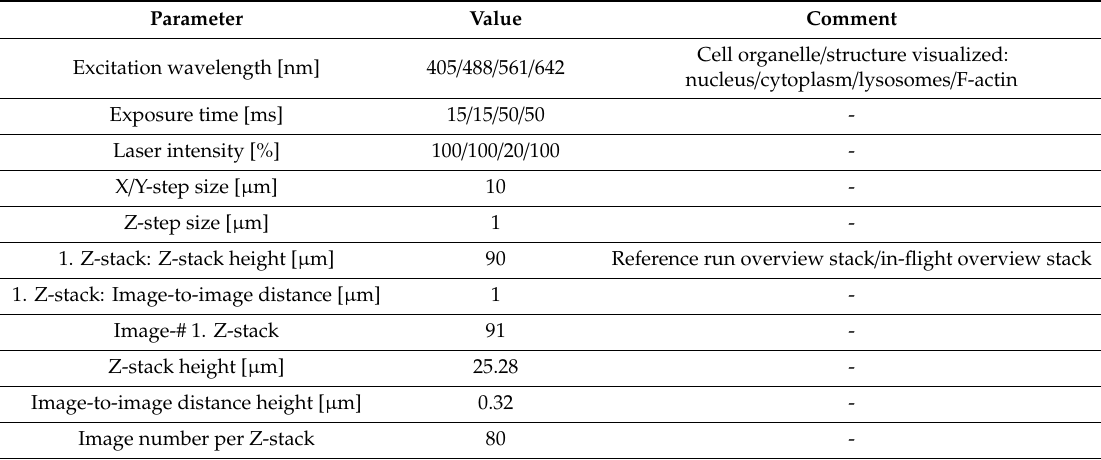
Table 2. Image acquisition parameters with the confocal laser spinning disk fluorescence microscope FLUMIAS on the TEXUS-54 suborbital rocket flight